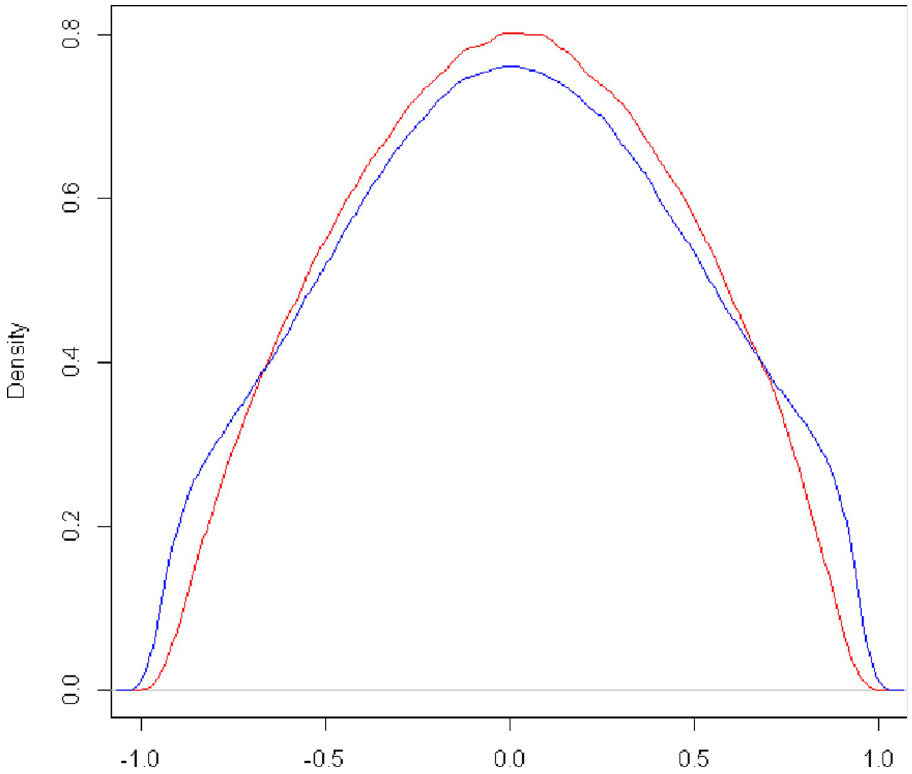
Fig 2. Posterior density for the genotypic correlation between the grain yield trait and flowering period in days for the model proposed by multi-traits and multi-environment. The red line represents the posterior density for environment 1, while the blue line represents the posterior density for environment